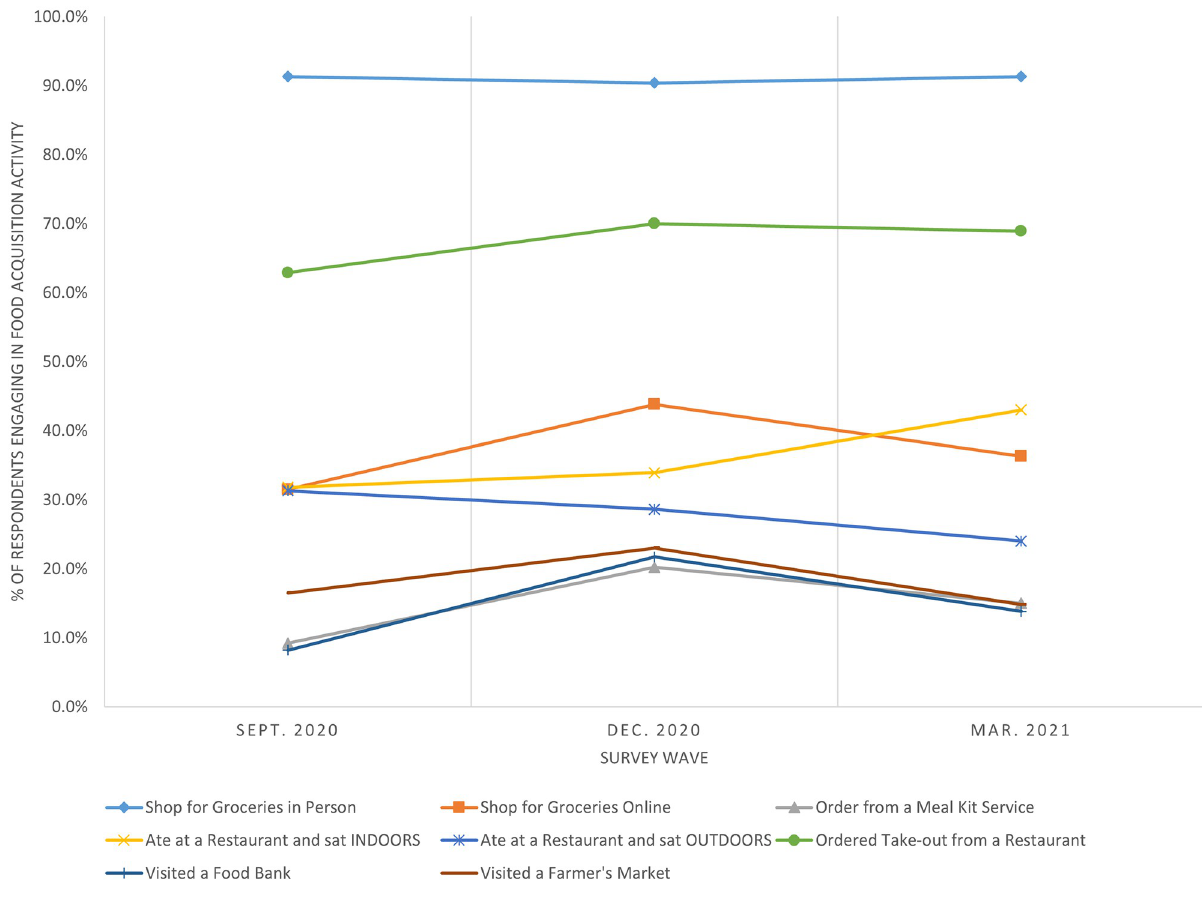
Fig 1. Reported shares of food acquisition activities performed by survey